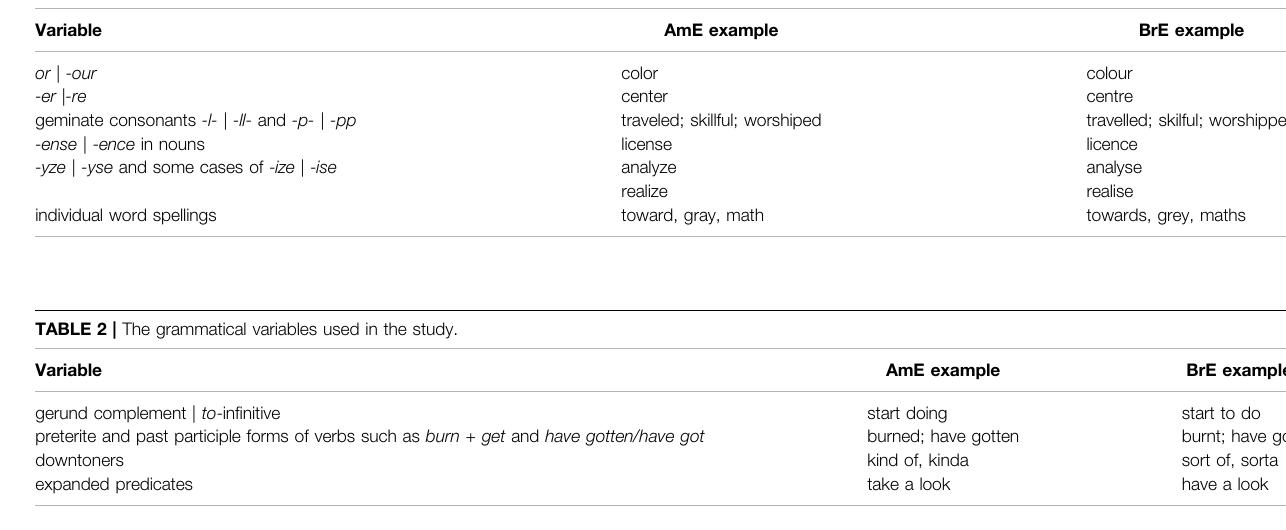
TABLE 1 | The examined spelling variables.